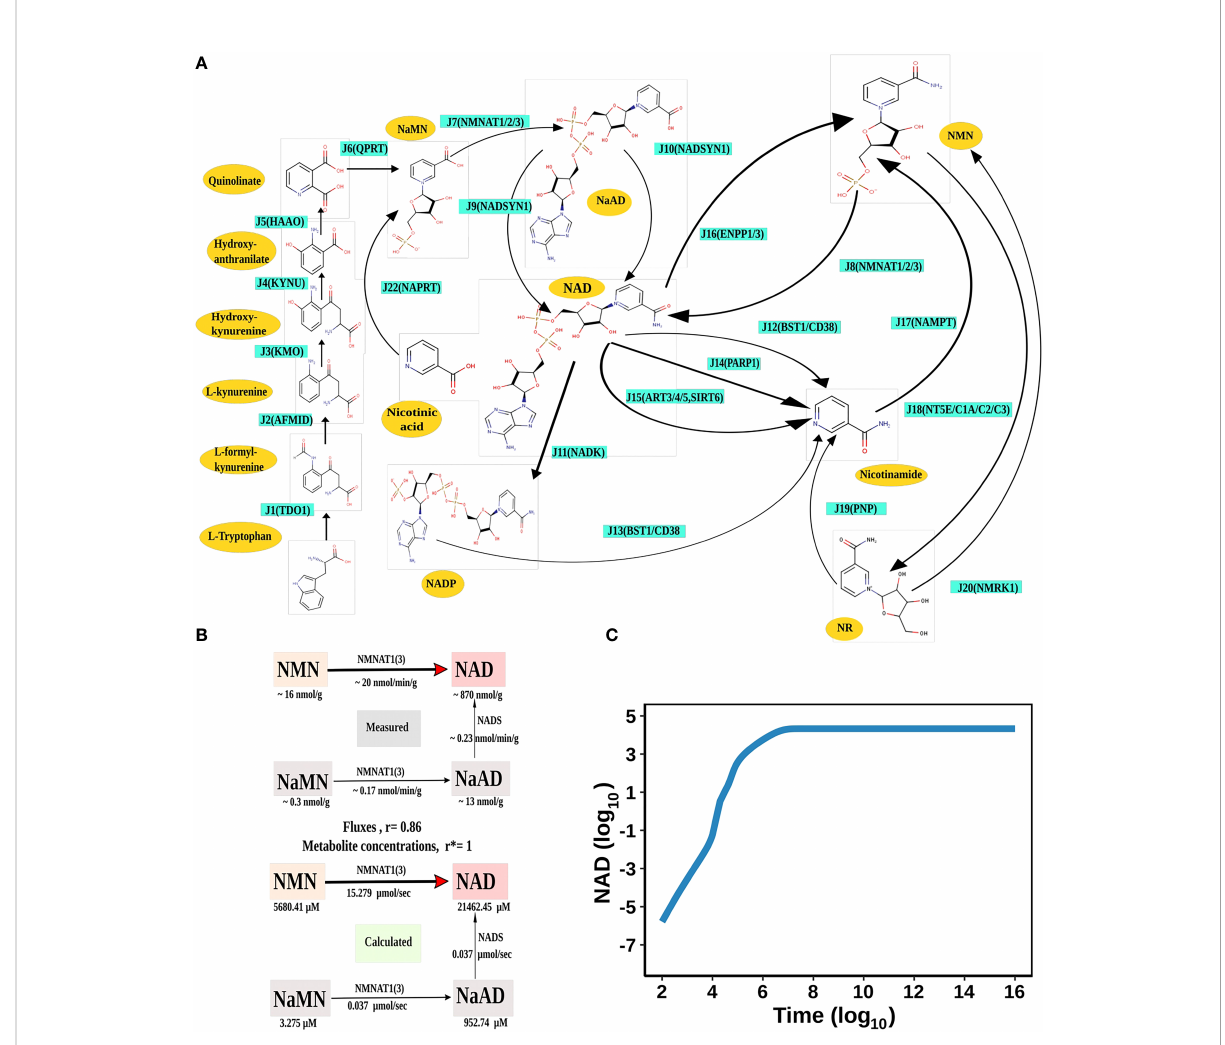
FIGURE 1 NAD Biosynthesis is perturbed in HCC. (A) Diagrammatic representation of the liver NAD net . Metabolites are represented as yellow nodes; enzymes are in cyan colour. NAD + can be synthesised by the three different routes - (A) Route I: de novo biosynthesis pathway starting with the precursor tryptophan (B) Route II: Preiss − Handler pathway from nicotinic acid and (C) Route III: NAD salvage pathway utilising nicotinamide and nicotinamide riboside for NAD + biosynthesis. Note: NAD represents total NAD in the system (both oxidised and reduced form). (B) Validation of the liver NAD net. The above panel (Measured) is adopted from the report of Mori et al. and represents the metabolic reconstruction of NAD biosynthesis in mouse liver tissue and re fl ects the main route of NAD generation is via NMN. The below panel (Calculated) is the reconstruction of NAD biosynthesis from steady-state concentrations and fl uxes obtained from model simulation. r is the Spearman correlation between measured and calculated fl uxes. r* is the Spearman correlation between measured and calculated metabolite concentrations. (C) Time course simulation of NAD levels for the base model. The blue curve shows the changes in NAD concentration (µM) (log 10 scale) with respect to time(s) (log 10